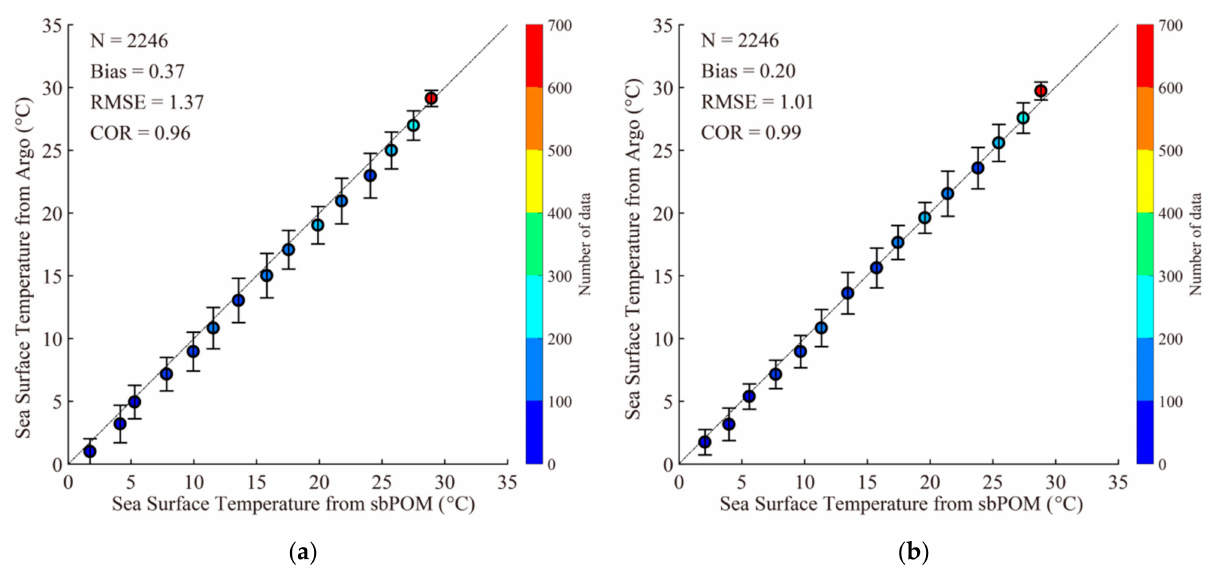
Figure 8. Comparisons of the SSTs from Argos with SSTs simulated using the sbPOM for 2 ◦ C bins between 0 and 30 ◦ C during the period 2–11 July 2015. ( a ) Not including the four effects induced by typhoon waves. ( b ) Including the four effects induced by typhoon